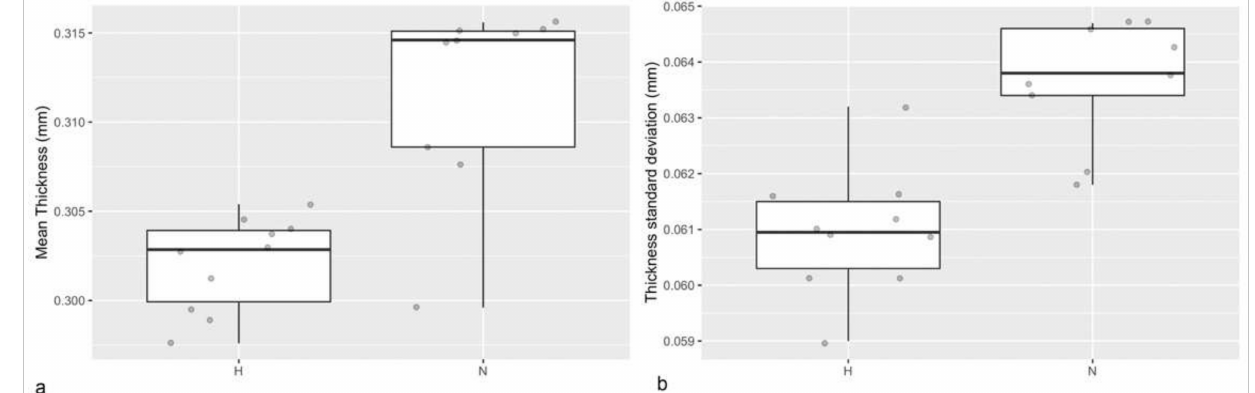
Figure 3. ( a ) Boxplot showing the mean thickness values of aligners thermoformed at narrow (N) and high (H) dental models. ( b ) Boxplot showing the standard deviation of the respective thickness values representing the material homogeneity.